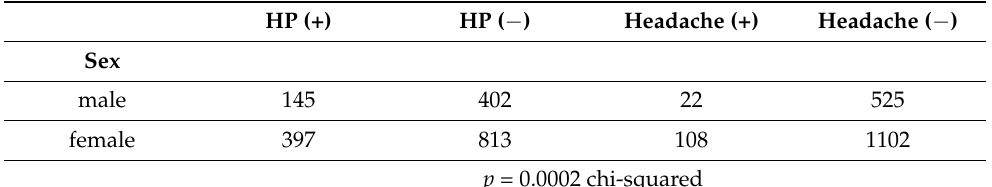
Table 3. Differences between sex-stratified